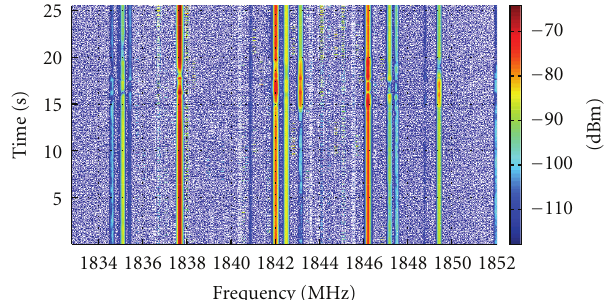
Figure 9: Spectrogram obtained by the wideband receiver IZT R3200 in GSM-1800